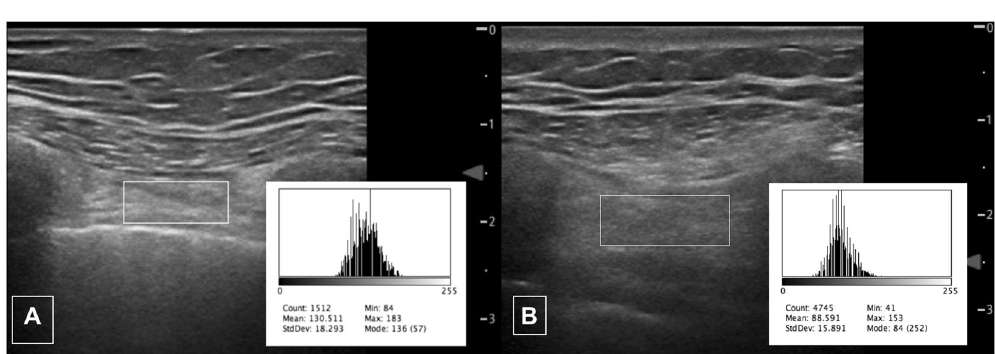
Figure 3. Echogenicity of parasternal intercostal muscle. Typical ultrasound images of parasternal intercostal muscle (right 3 rd intercostal muscle) with square to measure region of interest for quantitative grayscale analysis showing ( A ) higher echogenicity and ( B ) lower echogenicity. Insets depict respective histograms of grayscale analysis (range 0 [black] to 255 [white]) with mean value